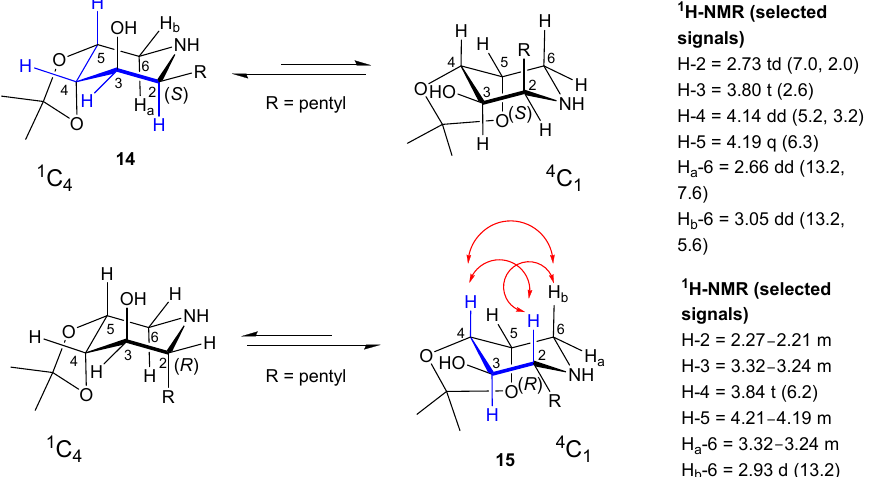
Figure 2. The two possible chair conformations of piperidines 14 and 15 . Dihedral angles between bonds analysed for the determination of the preferred conformation are shown in blue. Red double- ended arrows show the observed diagnostic NOE correlation peaks in the 1D-NOESY NMR